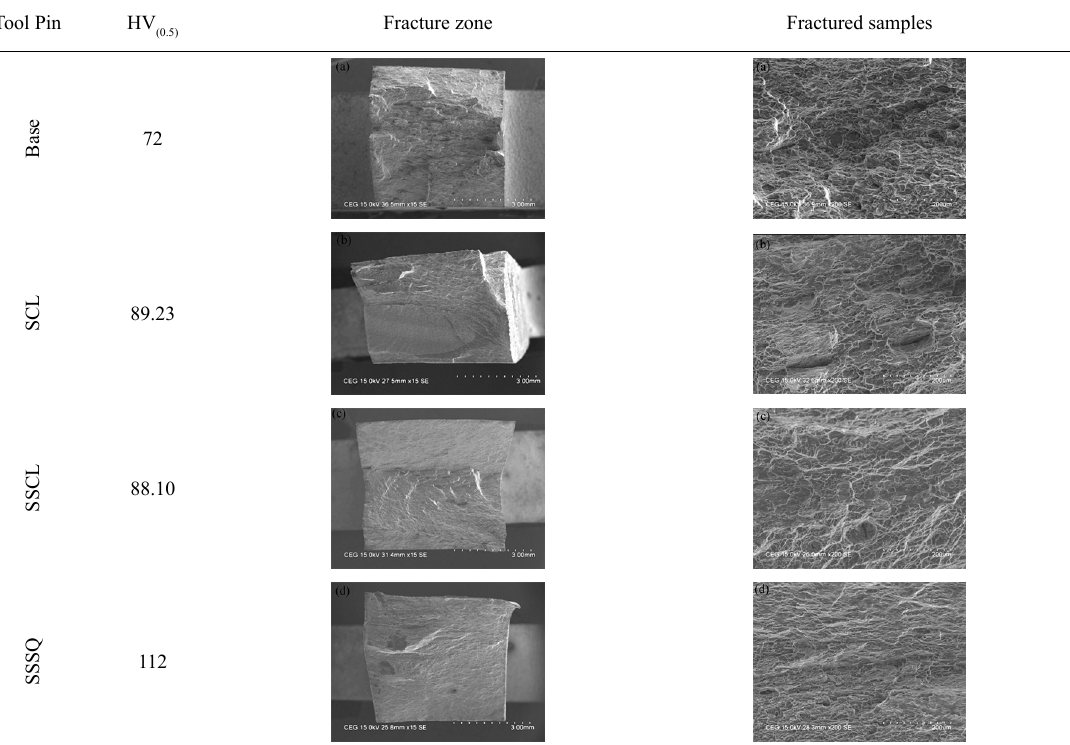
Table 4. Fracture surface of tensile specimens using different tool pin profiles. Tool